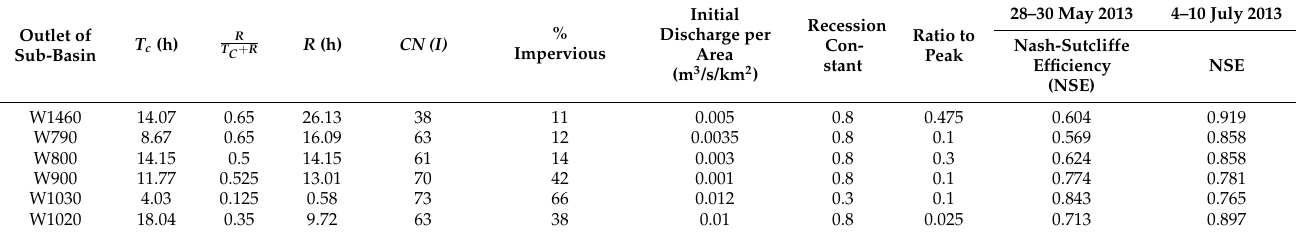
Table 9. HEC-HMS (Hydrologic Engineering Center’s Hydrologic Modeling System) model verification via parameter calibration for the events of 28–30 May 2013 and 4–10 July 2013. Outlet of